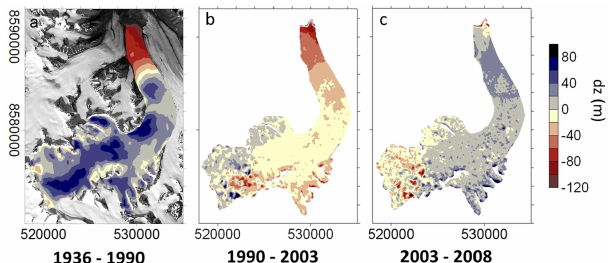
Fig. 5. Surface elevation changes on Polakkbreen flowing from SW to N. (a) Build-up in the upper part; thinning and retreat in the lower part. (b) Surge stage 2: lowering in the southern part of the upper basin. (c) Surge stage 2 at the transition to stage 3: more extensive lowering of the upper part, mass transfer and thickening in the lower part. Note that the lowermost terminus has not yet advanced and still displays thinning and retreat; furthermore some of the areas with the heaviest accumulation correspond to areas with initial